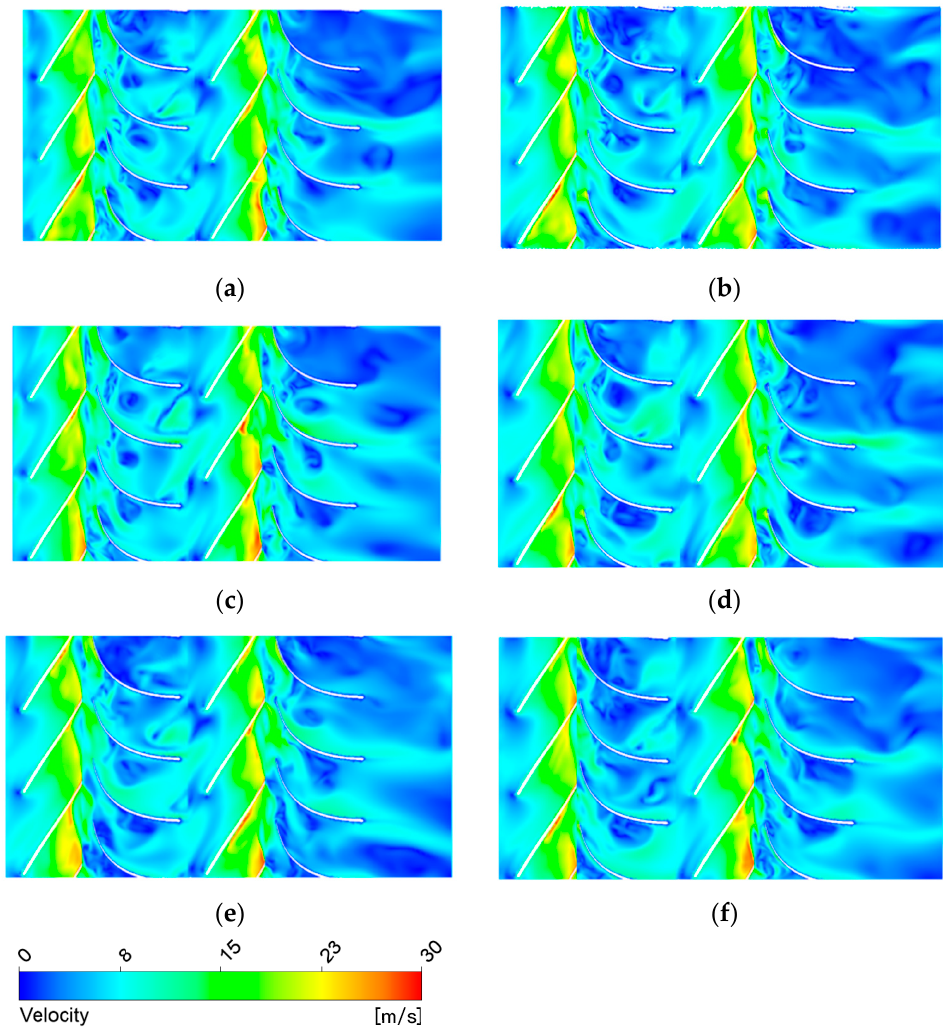
Figure 4. Velocity distribution on first-stage impeller-guide vane B2B view: ( a ) d p = 3 mm; ( b ) d p = 6 mm; ( c ) d p = 10 mm; ( d ) d p = 14 mm; ( e ) d p = 17 mm; ( f ) d p = 20 mm.